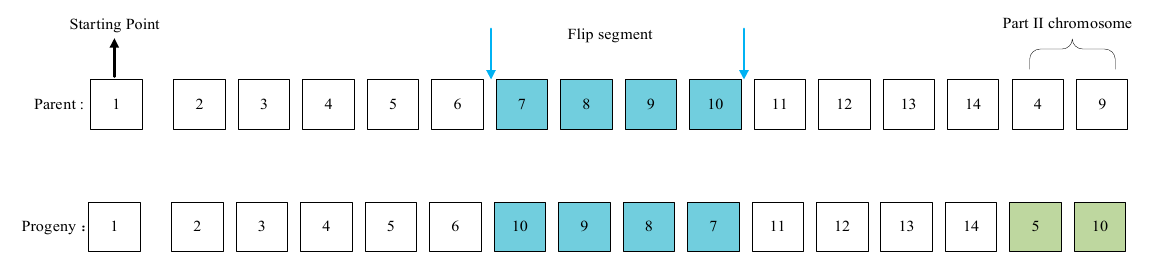
Figure 6. Inversion mutation operation ( m = 14). The exchange mutation randomly selects two genes in a chromosome to exchange positions, as shown in Figure